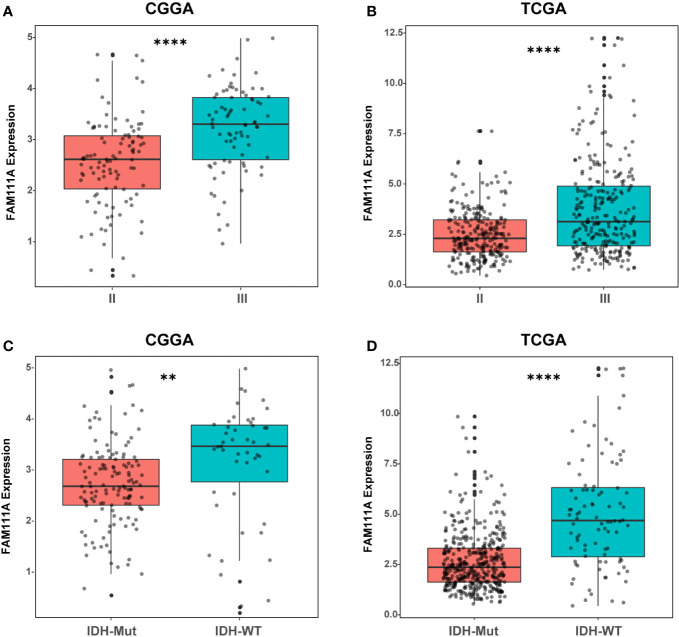
The mRNA expression of FAM111A in lower-grade glioma. (A, B) FAM111A was significantly increased in WHO grade III gliomas in Chinese Glioma Genome Atlas (CGGA) and The Cancer Genome Atlas (TCGA) dataset. (C, D) FAM111A was significantly increased in isocitrate dehydrogenase (IDH)-wildtype lower-grade glioma (LGG) in CGGA and TCGA dataset. *P < 0.05, **P< 0.01, ***P < 0.001, ****P < 0.0001.